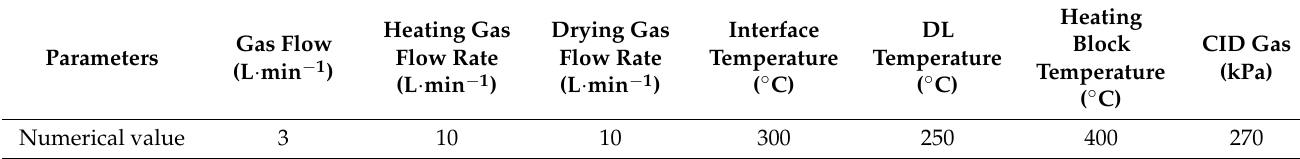
Table 5. Mass spectrometric